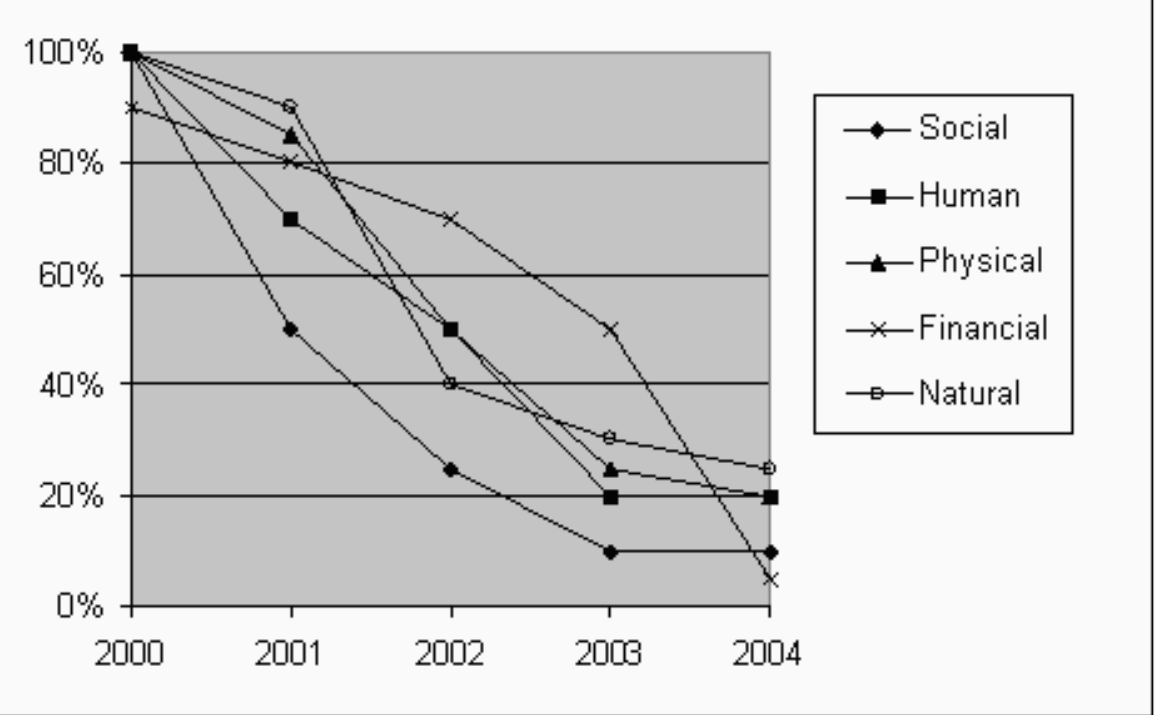
Fig. 3 . Postulated changes in levels of social, human, physical, financial, and natural capital during the transition from commercial wildlife ranching to resettlement under small-scale cattle ranching in the Shashe- Limpopo area of the South East Lowveld of Zimbabwe. The years before (2000) and during (2001–2004) the release ( W ) shown apply to both the commercial farmers and the new settlers, except for 2000, when the new settlers did not have access to the natural capital of the ranches. Levels of capital are represented relative to the maximum level reached during the period of history we analyze. Levels of capital can be compared within but not between categories of capital. The lines joining the time axes represent the trend between years correctly, but they do not track fluctuations. These levels are based on our opinions and interpretations of